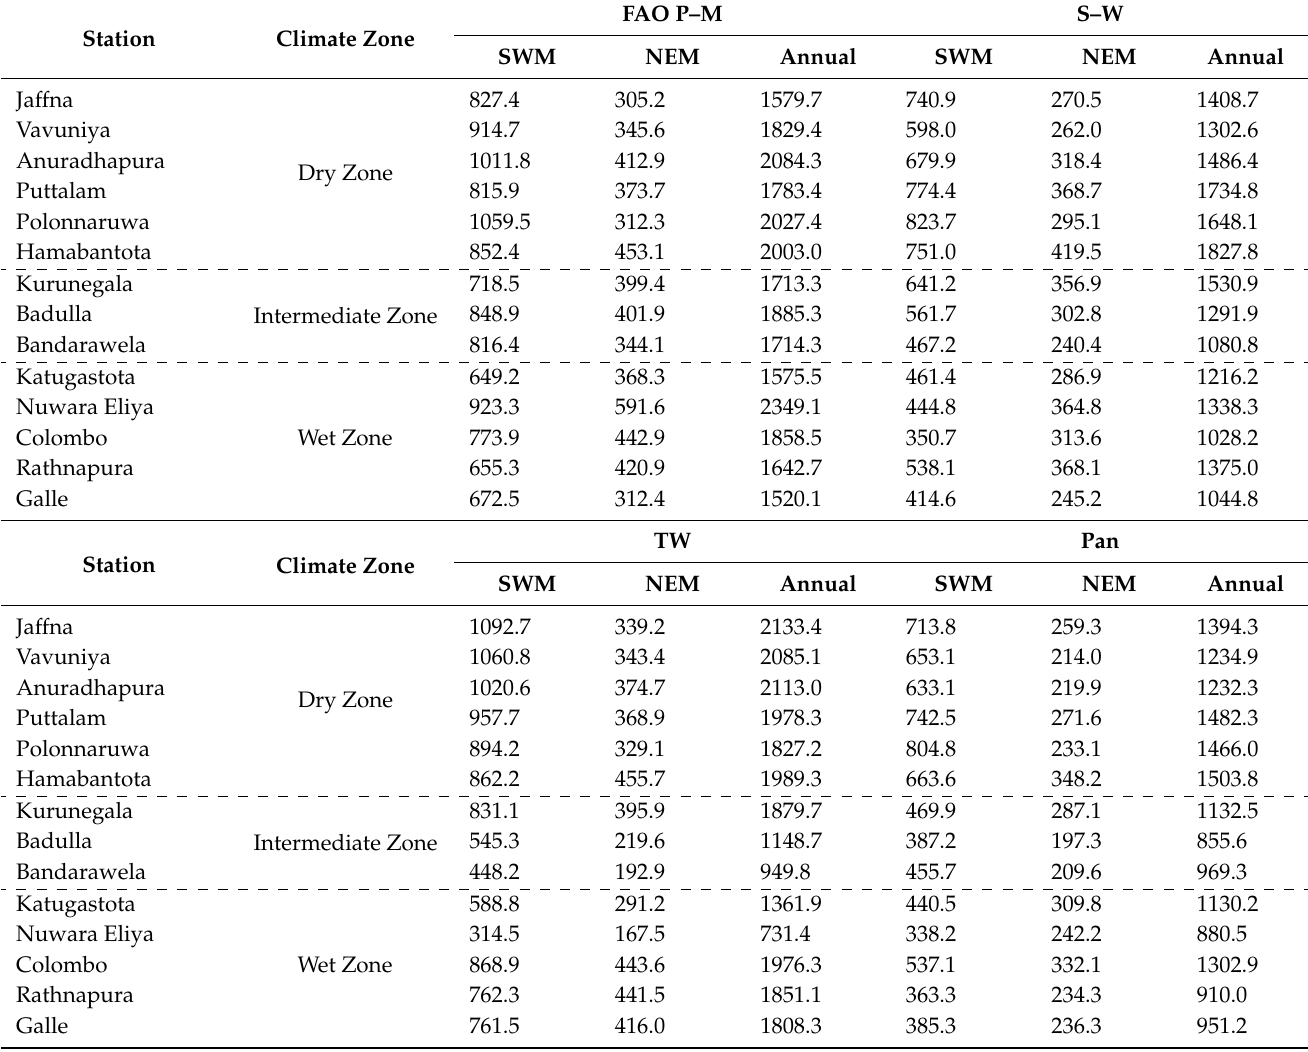
Table 3. Two monsoonal (SWM and NEM) and annual PET estimated by FAO P–M, S–W, TW and Pan methods (monthly estimates from 2009 to 2019 were averaged and summed up annually and